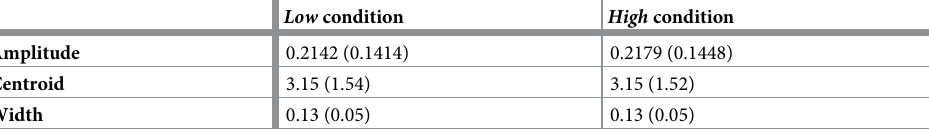
Table 6. Parameters of the gaussian-modelled grip force responses (means and standard